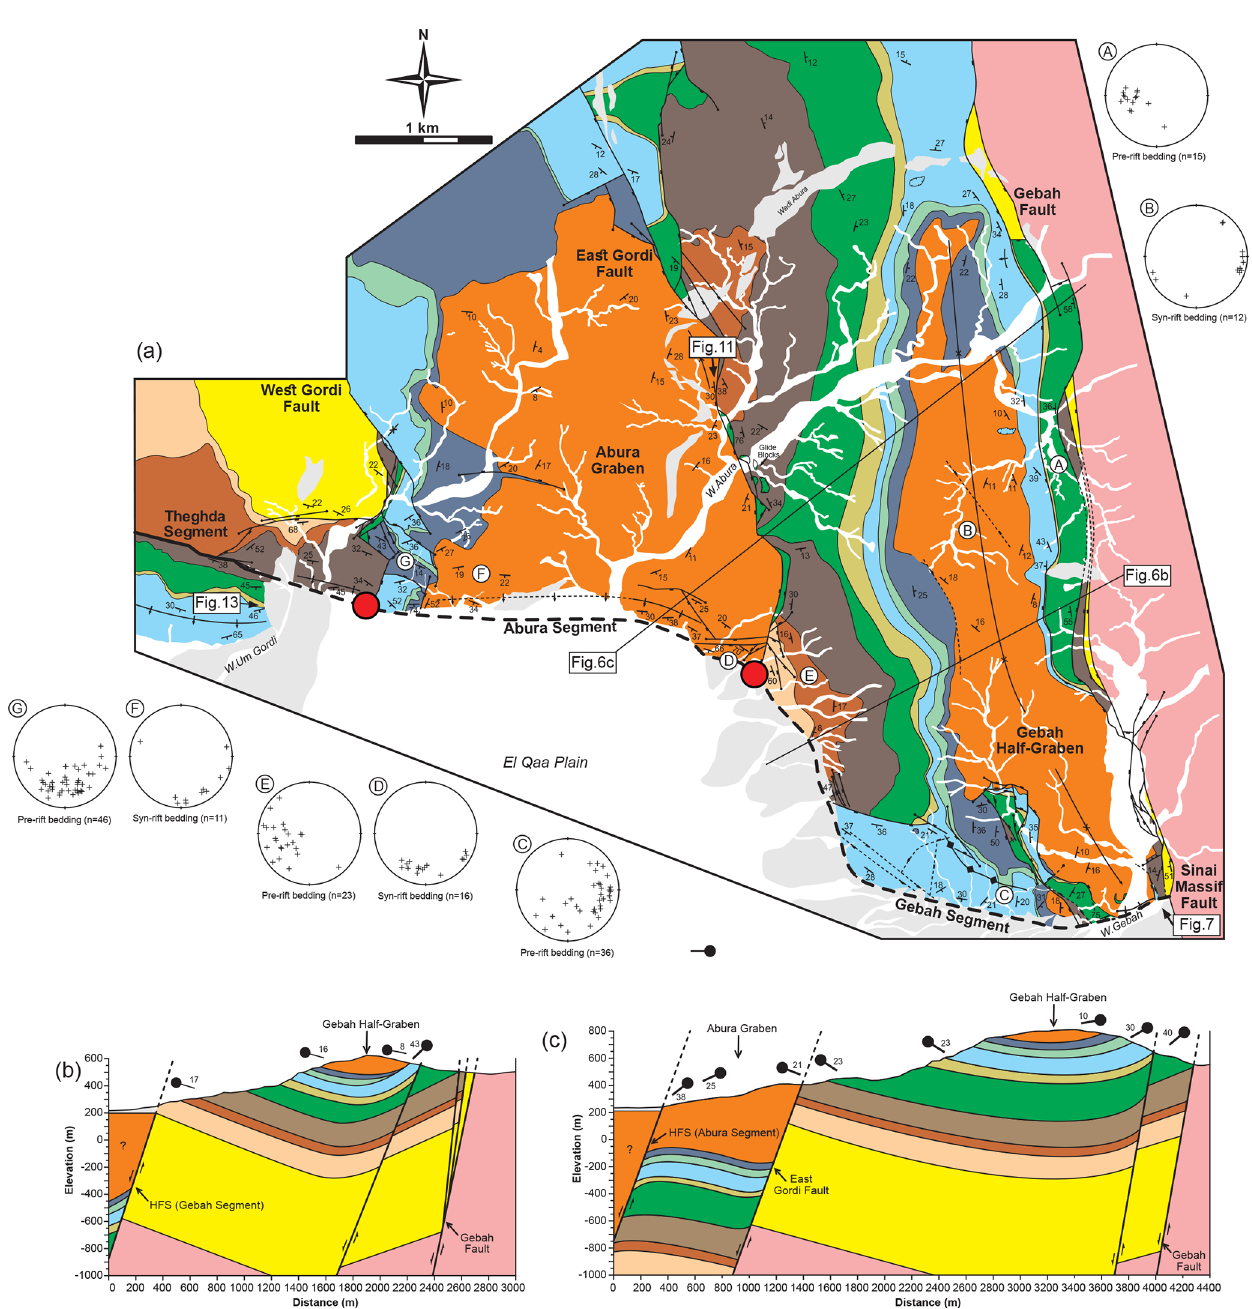
Figure 6. (a) Field map of the southern end of the Hadahid Fault System, showing the Gebah and Abura segments. Colour key to stratigraphic units is shown in Fig. 3a. Red dots indicate the approximate boundaries between the identified segments. Lower-hemisphere projection stereonets summarize the dip and dip direction of pre- and syn-rift bedding ( a–g ; location shown on map). The location of the photographs shown in Figs. 7, 11, and 13 and the cross sections shown in (b) and (c) are indicated. (b) Down-plunge cross section across the Gebah Segment. (c) Down-plunge cross section across the Abura